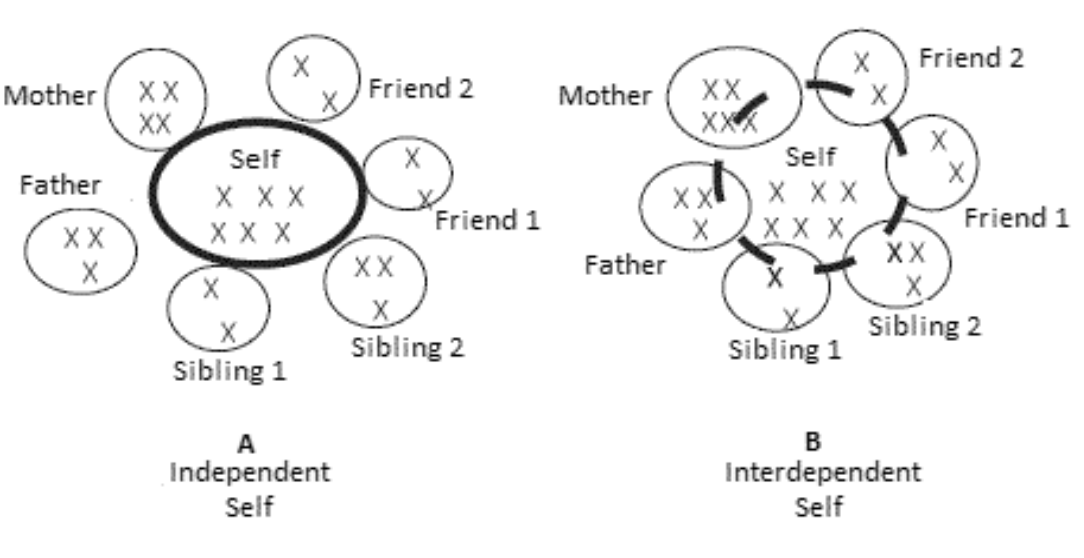
Figure 1: Independent (A) and interdependent